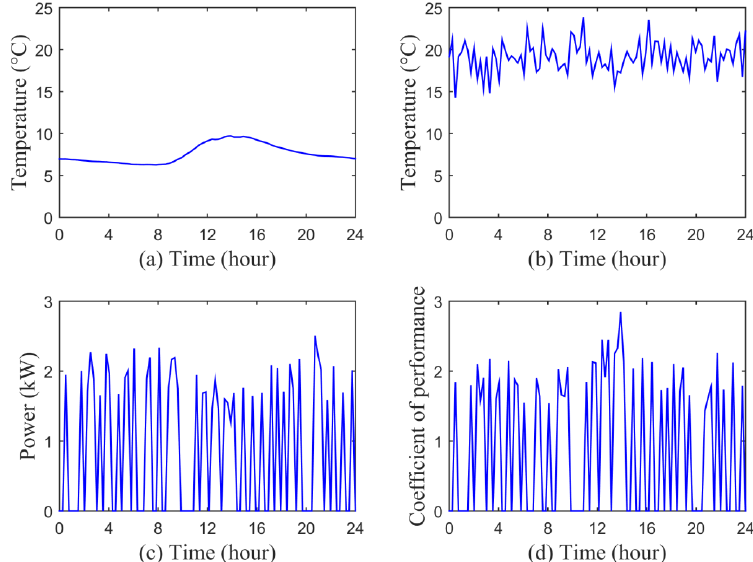
Figure 2. A one sample of all DHPs modelled in this paper. ( a ) The daily average of ambient temperature predicted based on historical temperatures and normal probabilistic distributions during winter in the UK by 2035; ( b ) The climate-controlled temperature of the building with the DHP unit based on Equation (9); ( c ) The electricity demand of the DHP unit based on Equations (7)–(10); ( d ) The coefficient of performance of that DHP unit based on Equation (6).